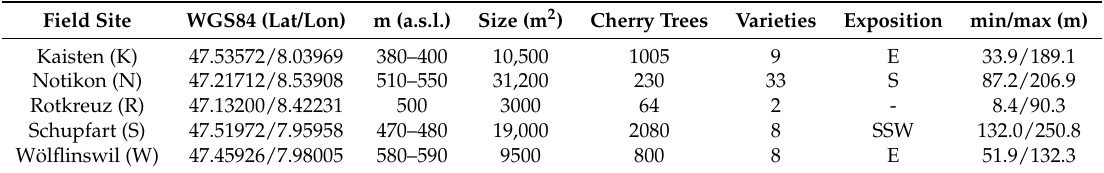
Table 1. Field site characteristics. Exposition: E = East, S = South, SSW = South Southwest. min/max = min and max distance between trap